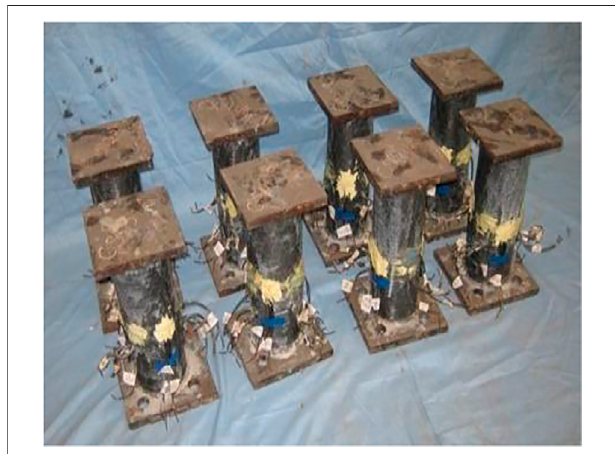
FIGURE 4 | Partial circular compression torsion specimen after loading. (A – F) Different axial compression ratio for those specimen.